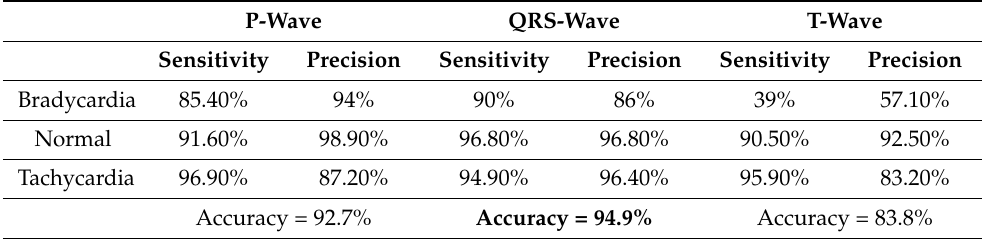
Table 2. Results of Irisgram and ResNet101.